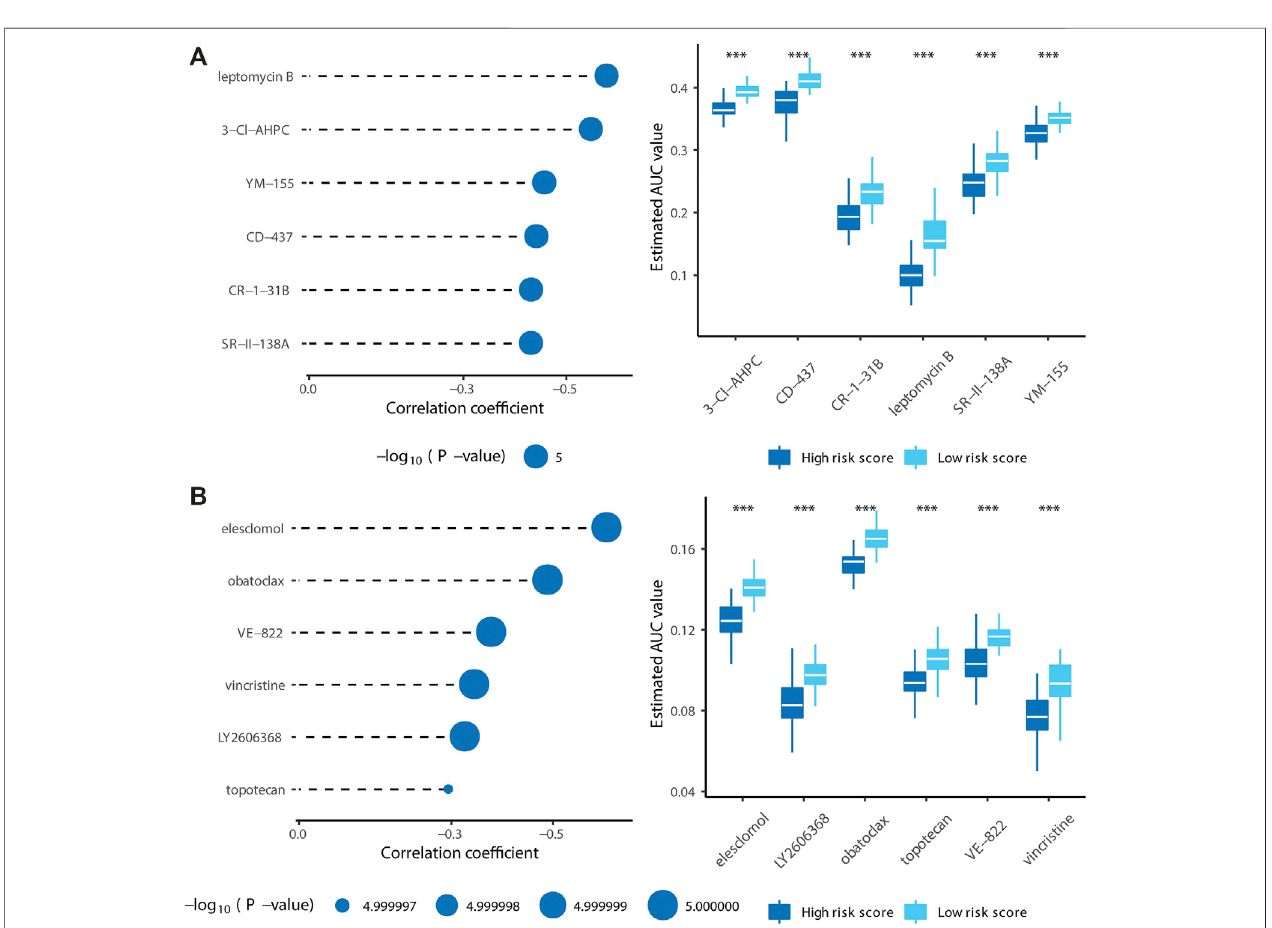
FIGURE 9 | Identi fi cation of candidate agents with higher drug sensitivity in patients with high risk score. (A) The results of Spearman ’ s correlation analysis and differential drug response analysis of six CTRP-derived compounds. (B) The results of Spearman ’ s correlation analysis and differential drug response analysis of six PRISM-derivedcompounds.Notethatlowervaluesonthey-axisofboxplotsimplygreaterdrugsensitivity.(*means p < 0.05,**means p < 0.01,***means p < 0.001,ns means p > 0.05, and p < 0.05 is de fi ned as statistically signi fi cant. And p < 0.05 is de fi ned as statistically signi fi cant).